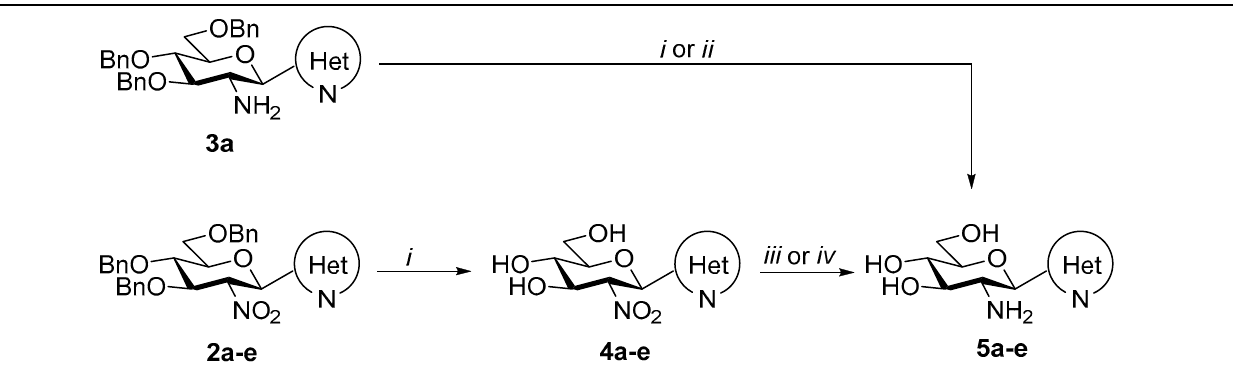
Table 2. Synthesis of C -(2 (cid:48) -amino-2 (cid:48) -deoxy- β - D -glucopyranosyl)azines.